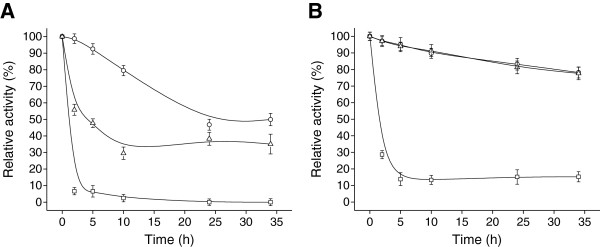
Solvent tolerances of free cells (A) and alginate-chitosan immobilized cells (B). Ethyl acetate (□), n-hexane (○), C4MIM·PF6 (△). Residual activities of the biocatalysts were measured in aqueous buffer after separating from the solvent, as indicated in the Experimental Section. Error bars show standard deviation from separate experiments conducted in duplicate.